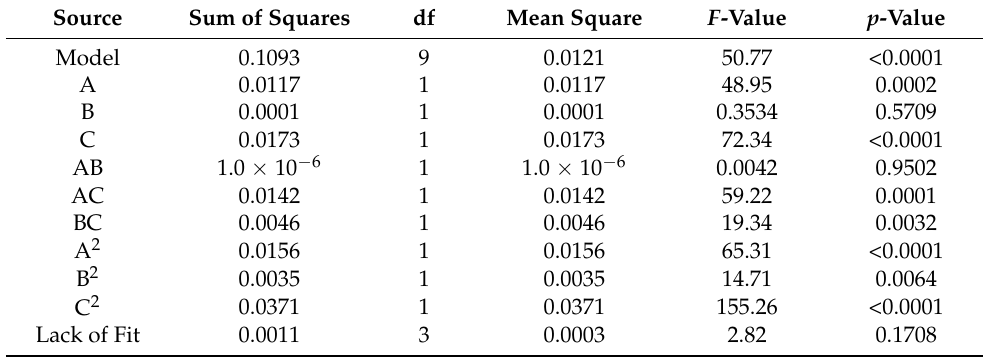
Table 3. Analysis of variance results of model.